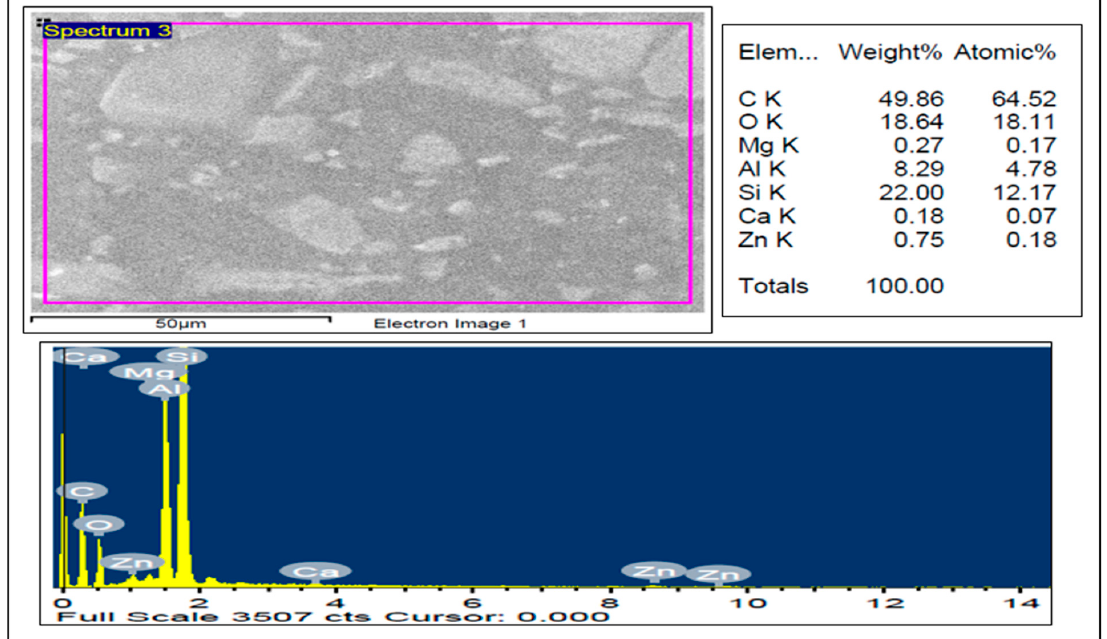
Figure 5 . FESEM-EDX analysis of Run 20-AA7075-SiC/fly ash composite .